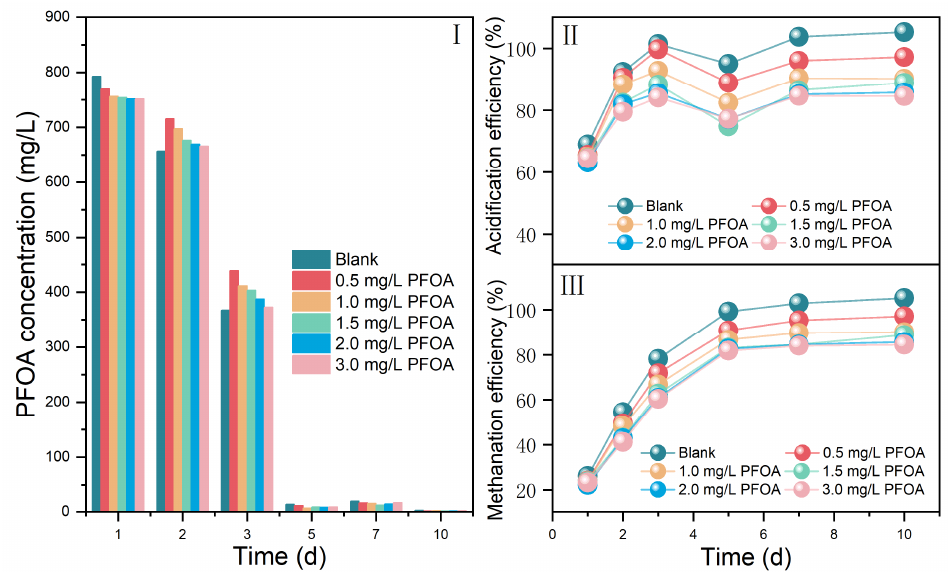
Figure 2. Changes of VFAs content in the reaction process ( I ), anaerobic digestion acidification efficiency ( II ), and methanogenesis efficiency ( III ) under PFOA exposure.